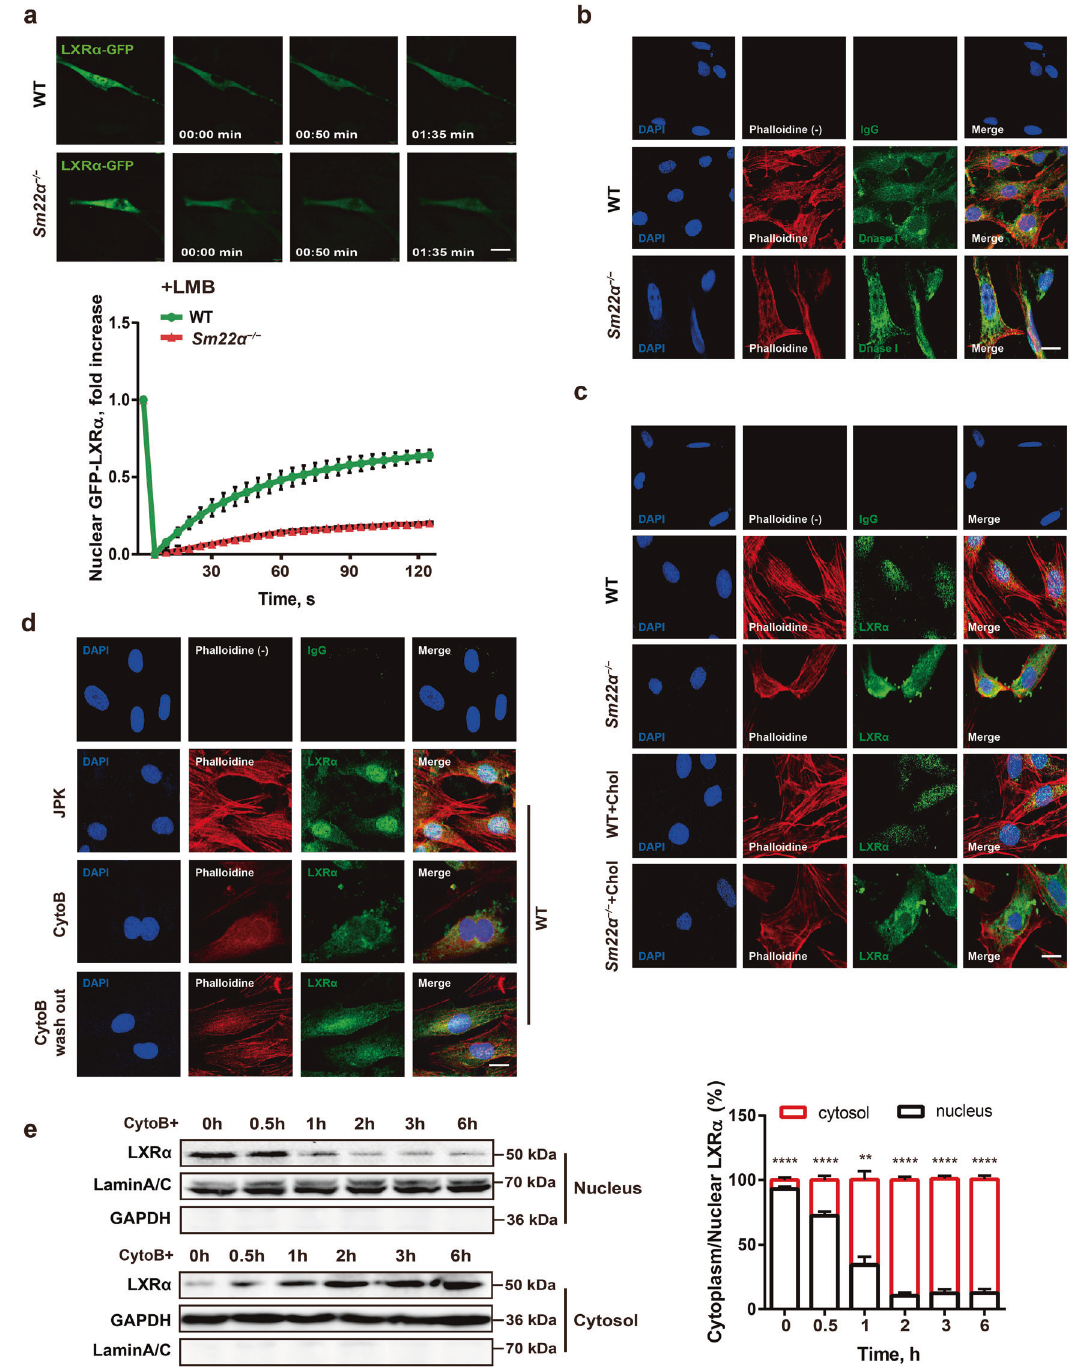
Fig. 6 The C-terminal domain mediates the interaction between G-actin and LXR α . a Representative immuno fl uorescence staining for LXR α -GFP (green) in WT VSMCs transfected with HA-ACTA2-CTD (red) or HA-ACTA2-NT (red). Scale bar, 15 μ m. b Representative immuno fl uorescence staining for LXR α -GFP (green) and HA-ACTA2-CTD (red) or HA-ACTA2-NT (red) in HEK-293A cells. Scale bar, 15 μ m. c LXR α -CTD-GFP (green) or LXR α -NT-GFP (green) was transfected into Sm22 α − / − VSMCs. Scale bar, 10 μ m. d LXR α (-CTD, -NT)-GFP (green) and HA-ACTA2-CTD (red) were co-expressed in HEK-293A cells. Scale bar, 10 μ m. e Interaction of HA-ACTA2 (-FL, -CTD, -NT) and GST-LXR α (-FL, -CTD, -NT) proteins analyzed by in vitro pull-down assay ( n = 3). f Schematic representation of a working model in which SM22 α inhibits VSMC-derived foam cell formation by blocking actin-LXR α signaling ameliorating atherosclerosis. Data and images represent at least three independent experiments.